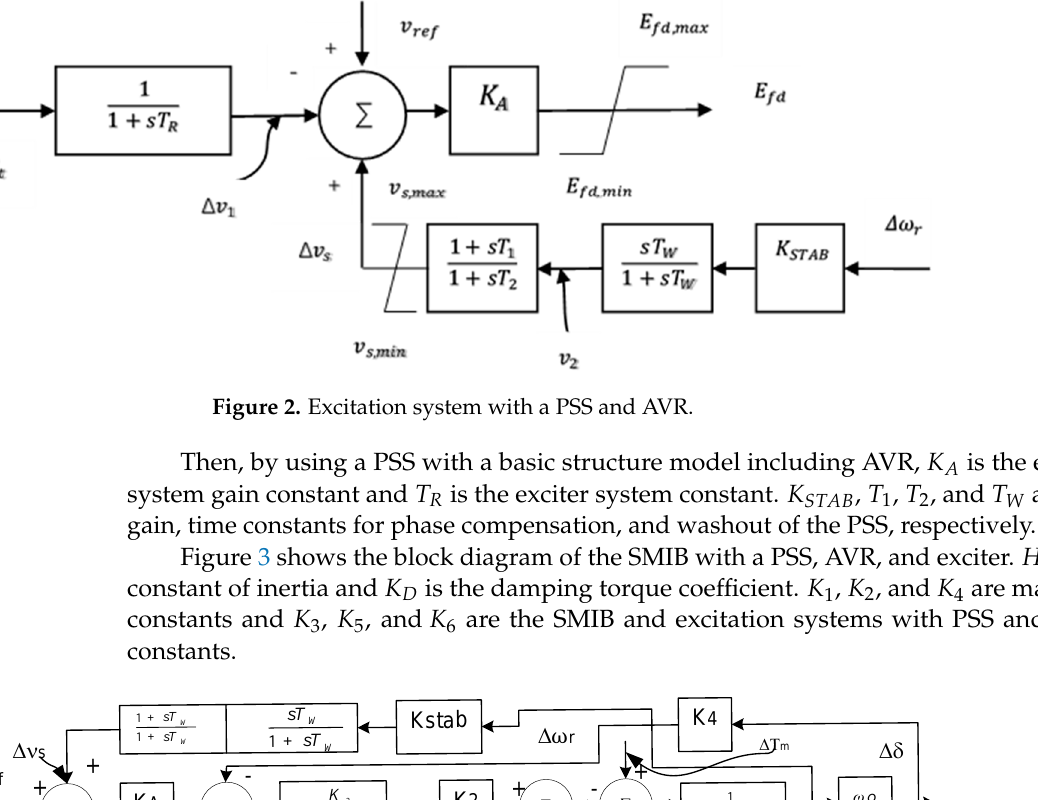
Figure 1. Machine connected to a large system.